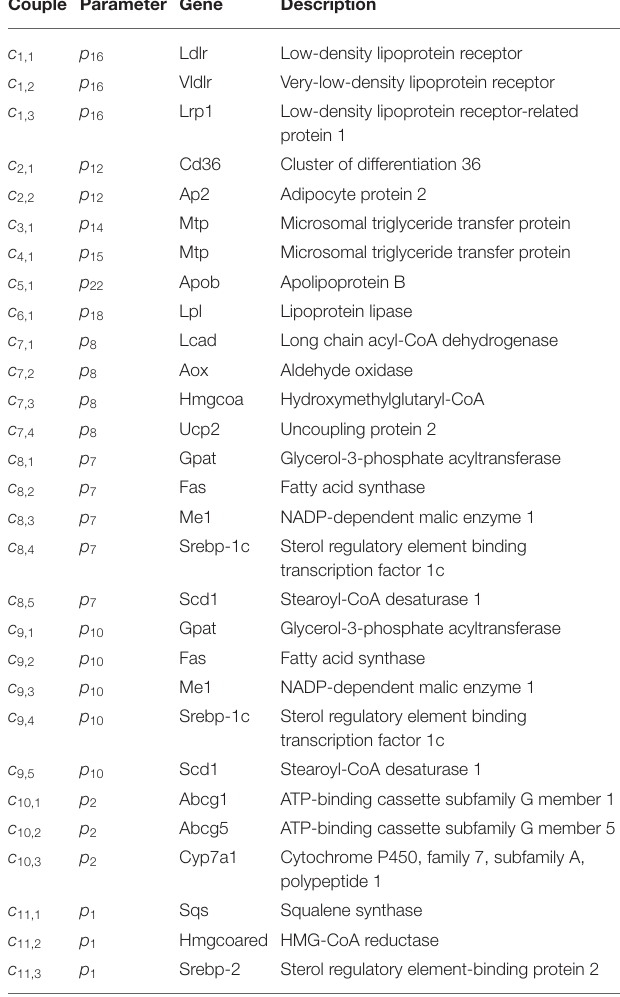
TABLE 3 | Parameter-gene couples, linking 23 genes to 11 model parameters. Couple Parameter